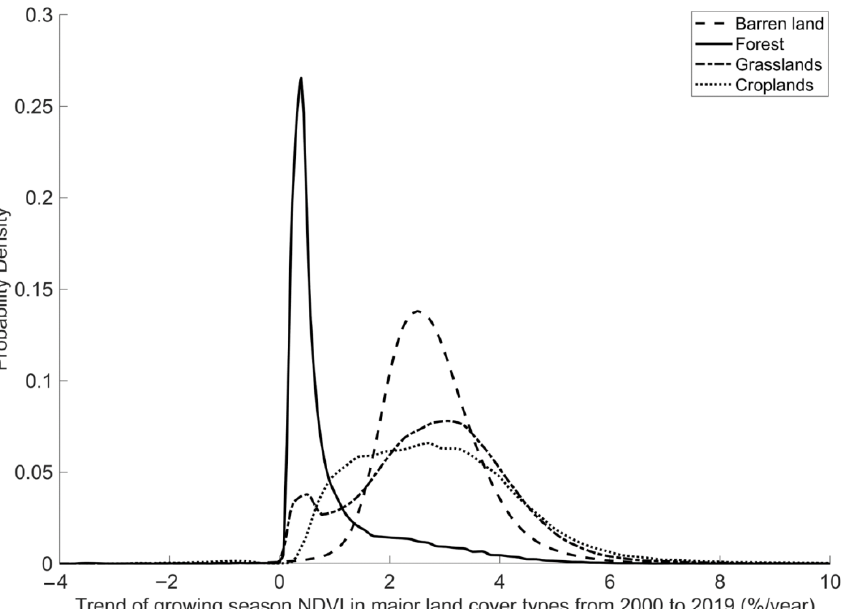
Figure 5. Frequency distribution of the trends of growing season NDVI for major land cover types in the study region from 2000 to 2019. Almost all of the trends are positive. The bimodal frequency distribution of the trends for grasslands suggests there are two categories of grasslands.